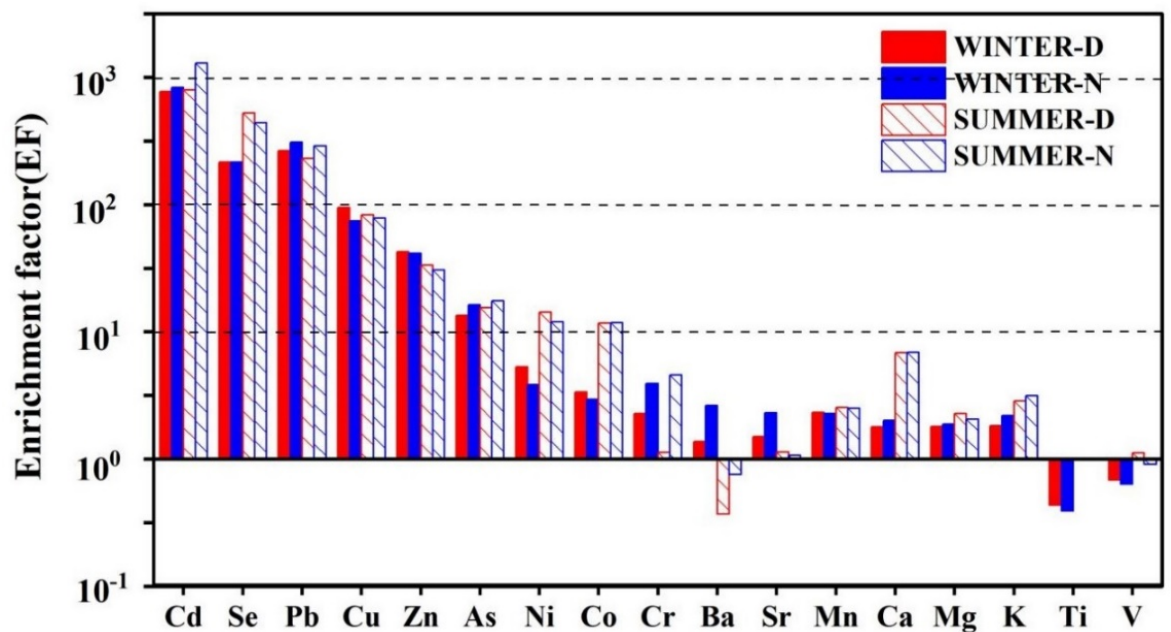
Figure 5. Enrichment factors (EFs) of elements in Lanzhou (WINTER-D: winter daytime, WINTER-N: winter nighttime, SUMMER-D: summer daytime, SUMMER-N: summer nighttime).